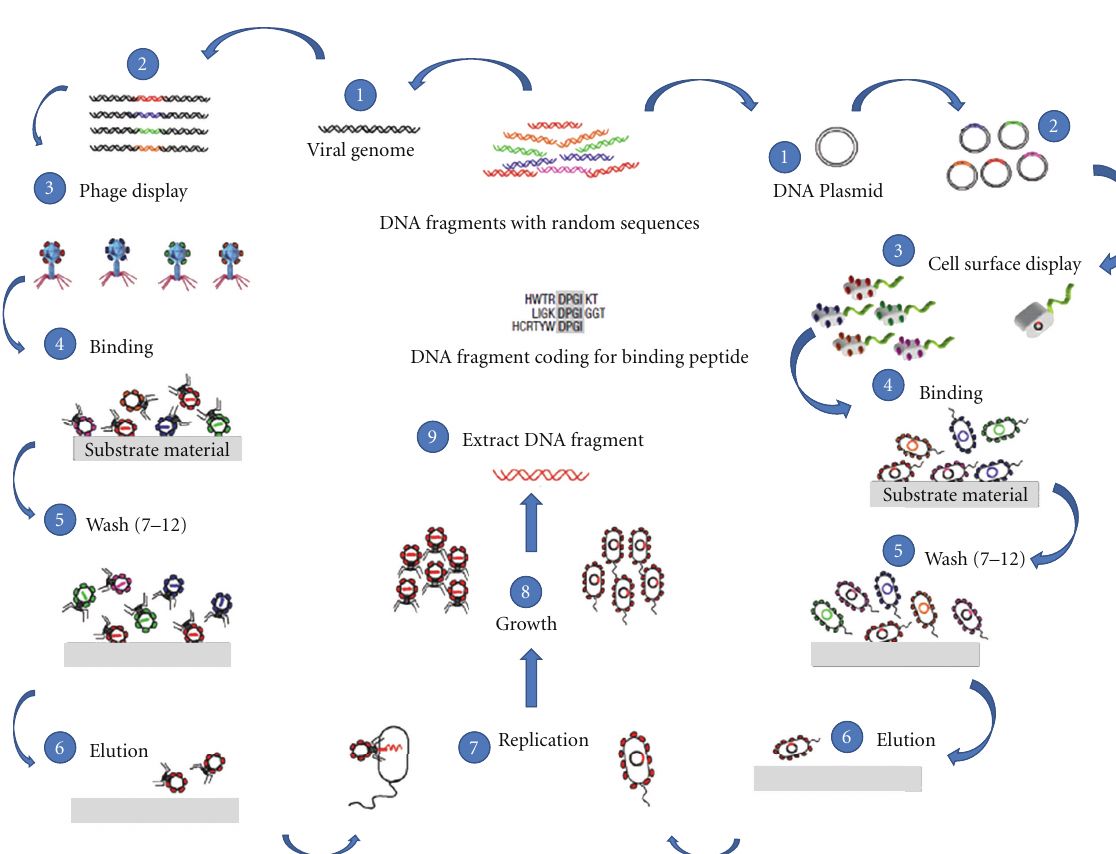
Figure 1: Phage display and cell surface display. Principles of the protocols used for selecting polypeptide sequences that have binding a ffi nity to given inorganic substrates (Source: Nat Mater. 2003, 2(9):577-85.)